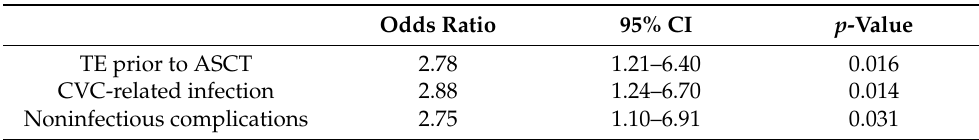
Table 3. Multivariate analysis model determining factors that affect CRT in patients with MM undergoing